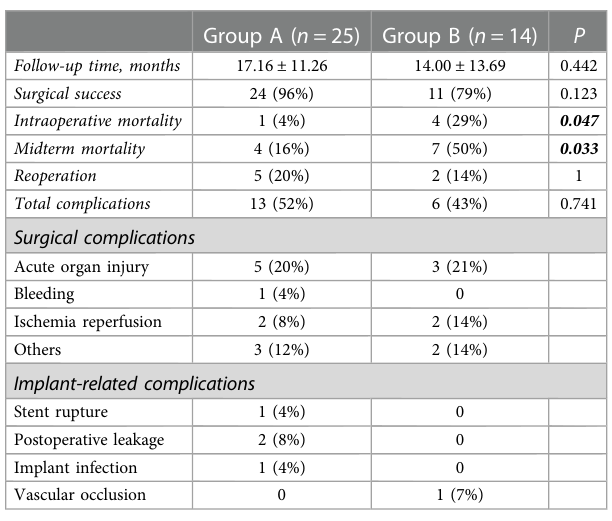
TABLE 3 Patient ’ s clinical end